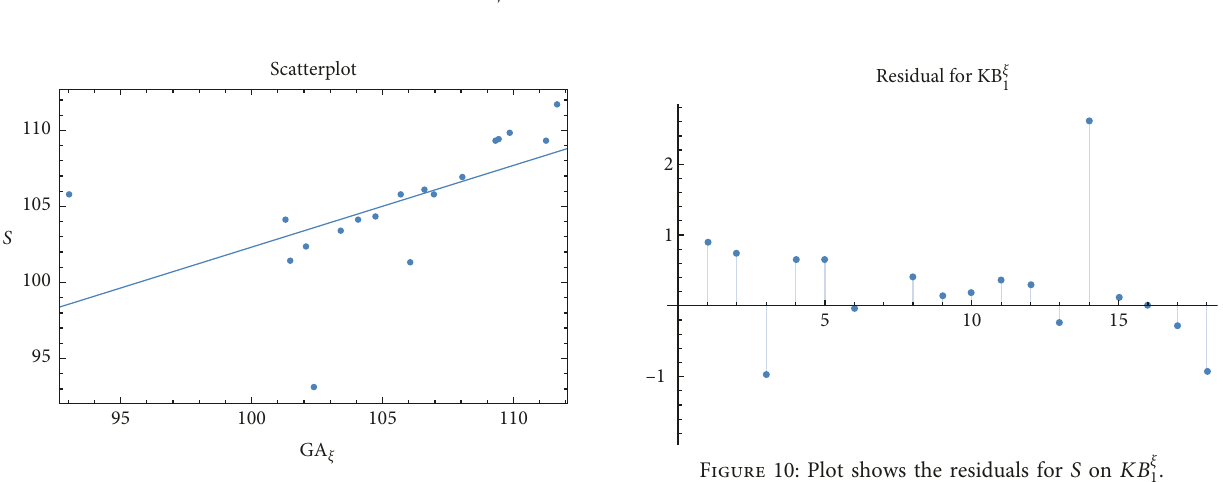
superimposed by the fitted ξ